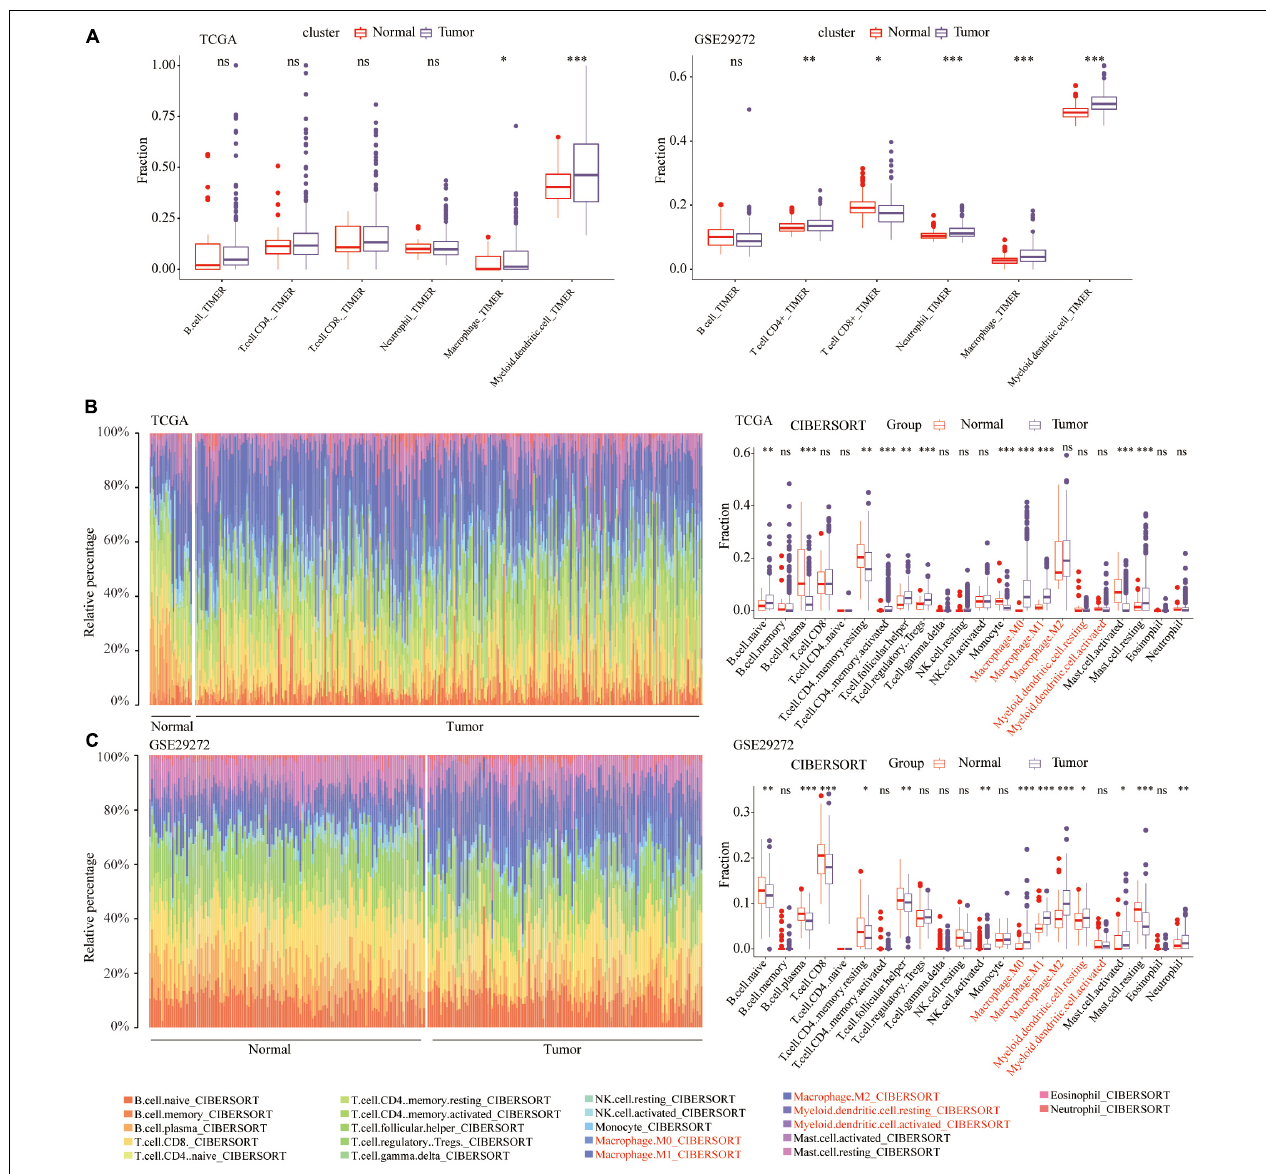
FIGURE 2 | Immune cell infiltration landscape in STAD patients. (A) Comparison of the abundance of six types of immune cells between normal and STAD tissues. The relative proportion and comparison of 22 immune cell between normal and STAD tissues in the (B) TCGA and (C) GSE29272. * p < 0.05, ** p < 0.01, *** p <